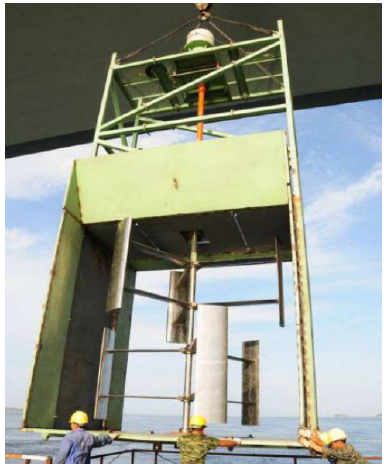
Figure 27. A 15 kW vertical-axis direct-drive TCPGS. Reproduced from [73].